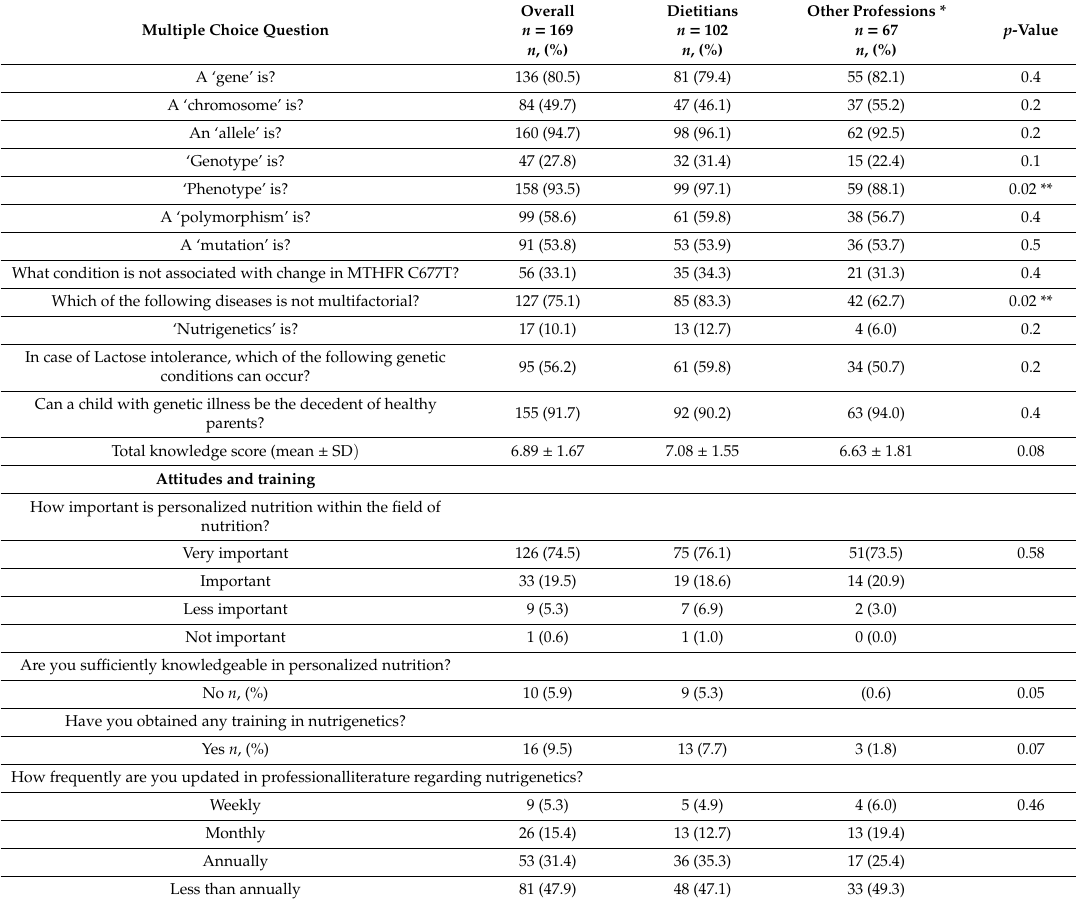
Table 2. Professionals’ attitudes, training, and knowledge of genetics and nutrigenetics ( n